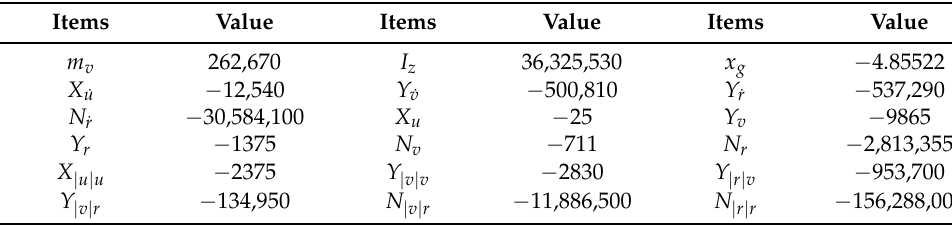
Table 1. Model parameters.